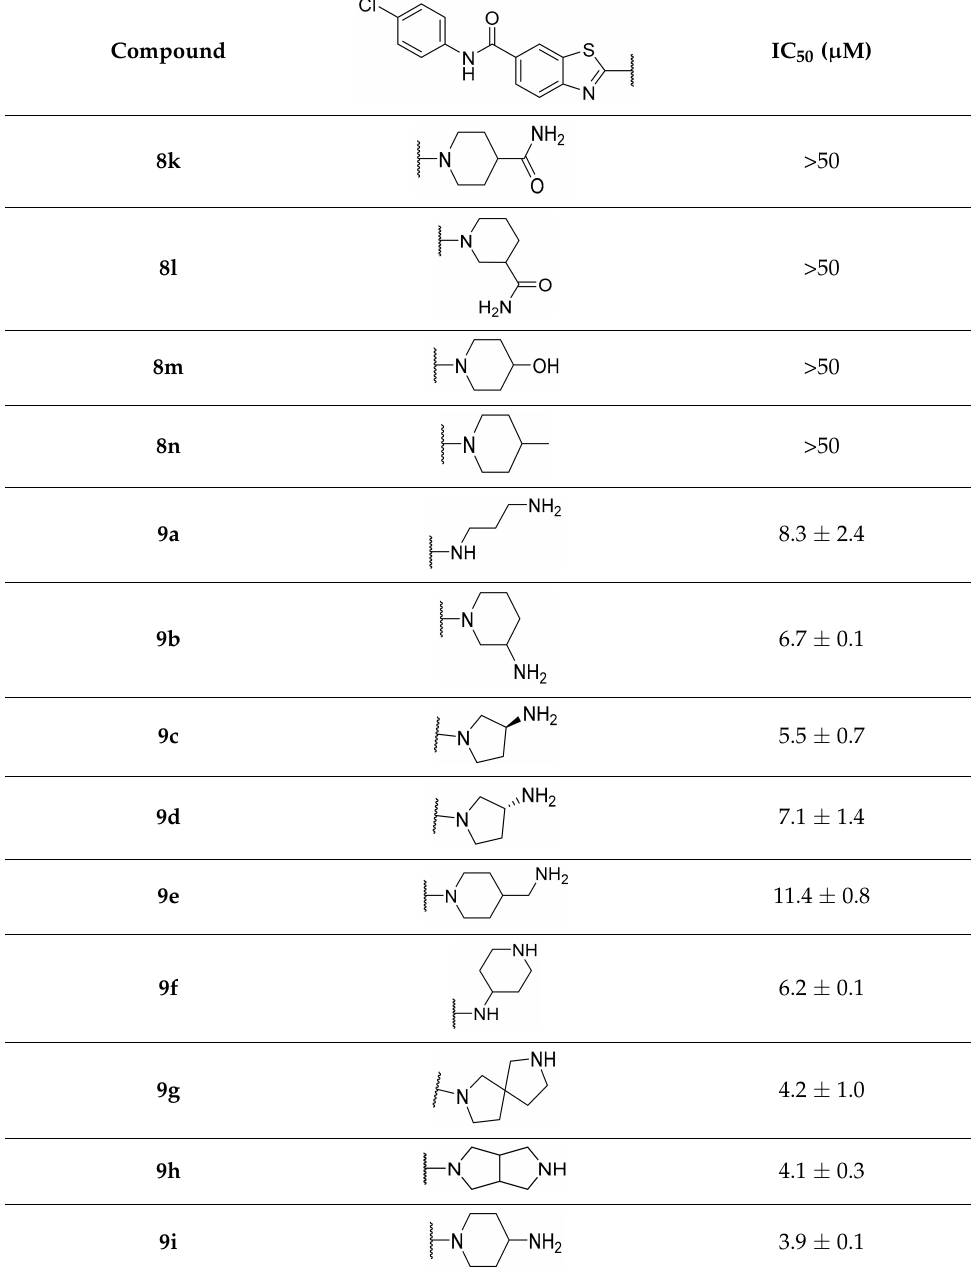
Table 2. IC 50 values for the antiproliferative activities of the synthesized benzothiazoles 8k–n and 9a–i in the MCF-7 breast cancer cell line: exploration of the structure–activity relationships at position 2 of the benzothiazole